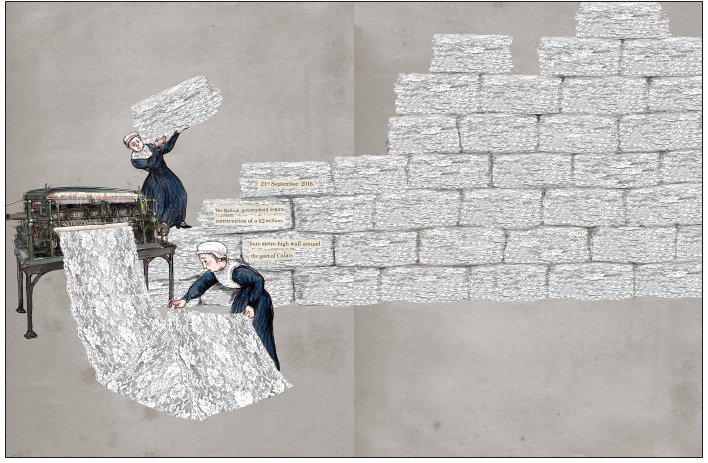
Figure 3: Kate Evans (2017) Threads from the Refugee Crisis (New York: Verso, 176–177). © Verso New York. Image presented with permission of Kate Evans and